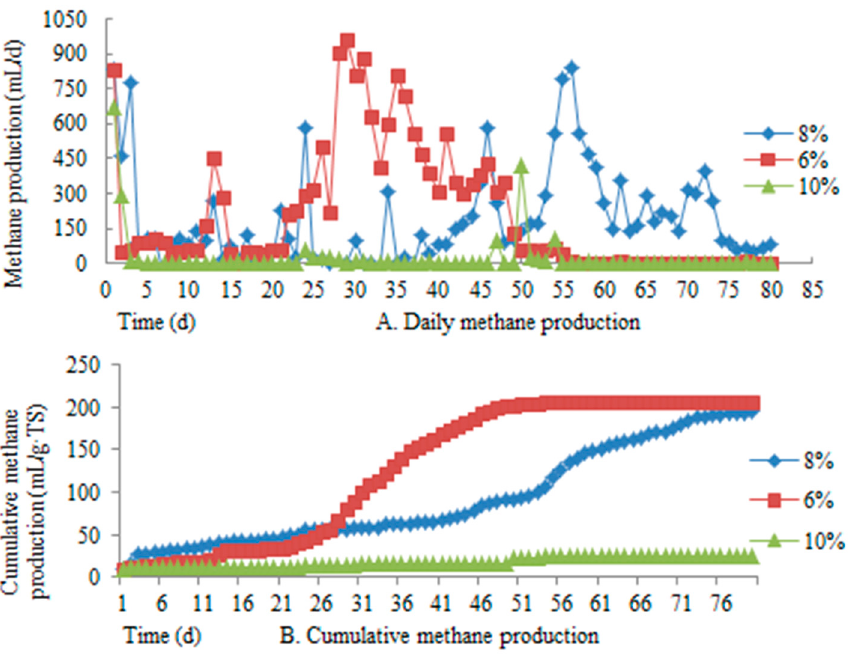
Figure 8. The change in methane production with different total solids (TSes).